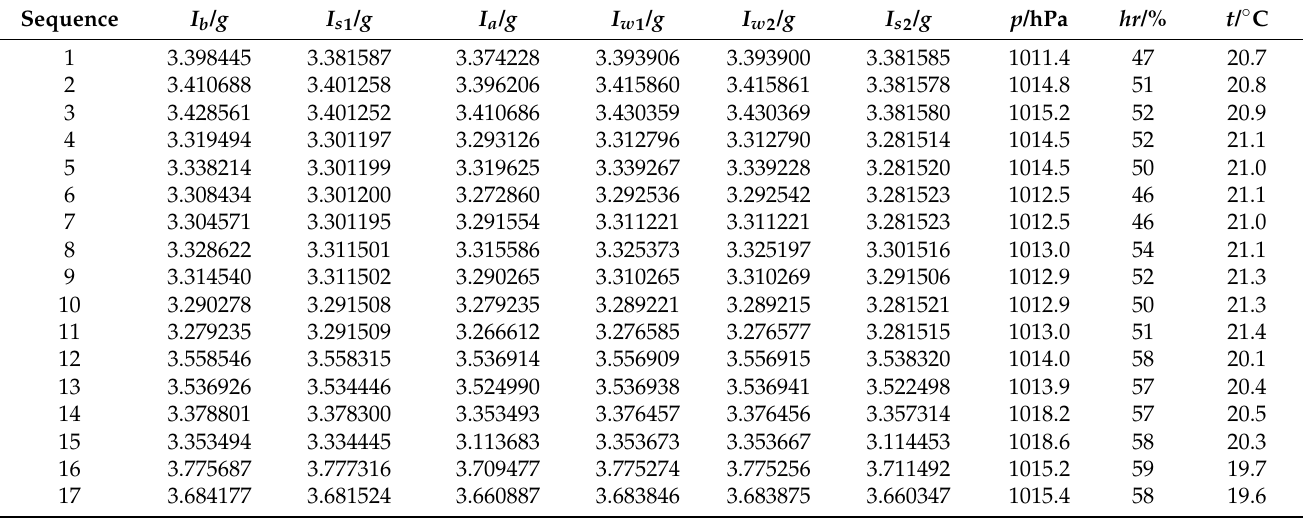
Table 2. Balance reading and environmental parameters obtained for each weighing